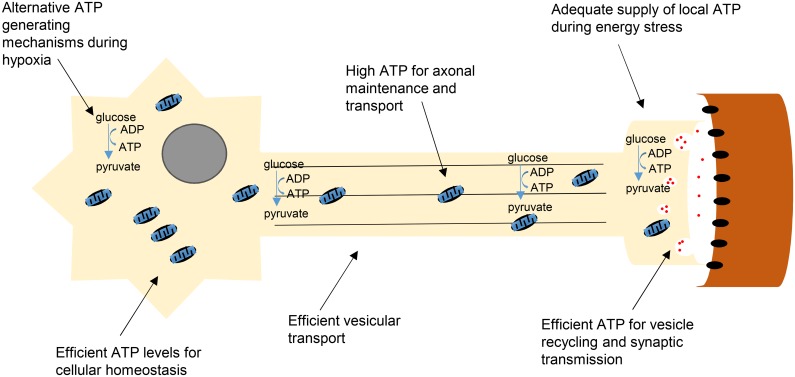
Summary model showing ATP-generating pathways likely to influence the vulnerability status of MNs in SMA.Efficient ATP generation through different processes maintains levels in energy demanding MNs, critical for their function and survival during disease. Certain motor neuron pools possess inherently higher bioenergetic capacities that provide protection during cellular insult both at the cell body and at the NMJ. Efficient ATP generated from mitochondria allows cellular homeostasis to be maintained. During hypoxia, glycolytic pathways are employed to meet acute ATP demand, particularly at the NMJ, critical for vesicular recycling and synaptic transmission. Mitochondrial transport along the axon provides local ATP to maintain axonal integrity. Glycolytic machinery present along the axon allows for fast vesicular transport down to the NMJ to deliver packaged proteins for pre-synaptic function.